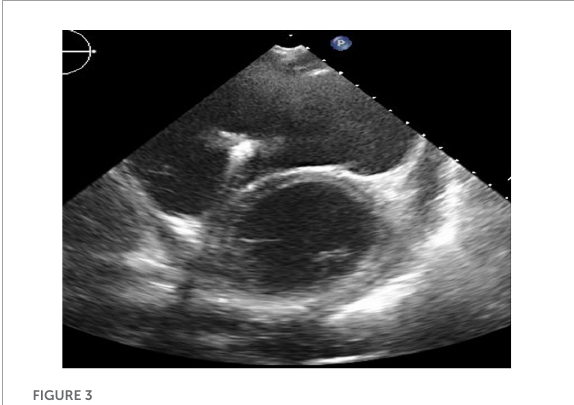
FIGURE3 Short-axis view at end-diastolic phase of transthoracic echocardiography in Case 2. Note that the right ventricle is much larger than the left ventricle.